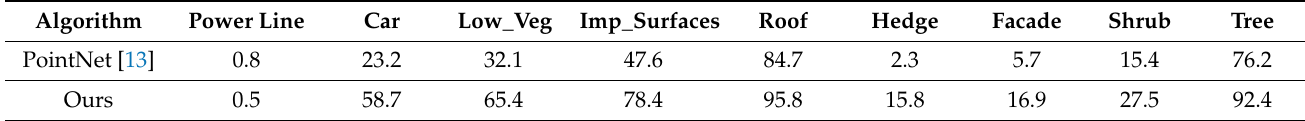
Table 7. Accuracy comparison of different classification methods